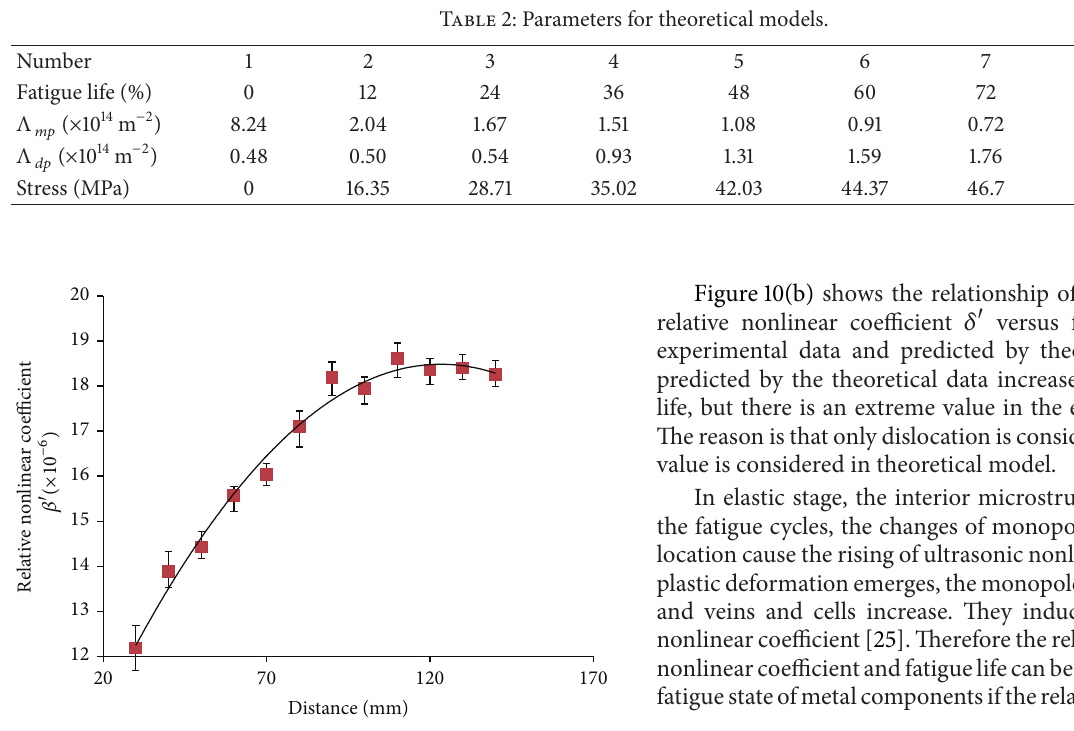
Figure 7: Variation in relative nonlinear coefficient 𝛽 󸀠 as a function of propagation distance.